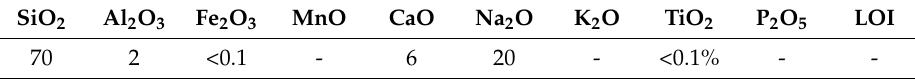
Figure 2. Particle size distribution results of fine aggregate.